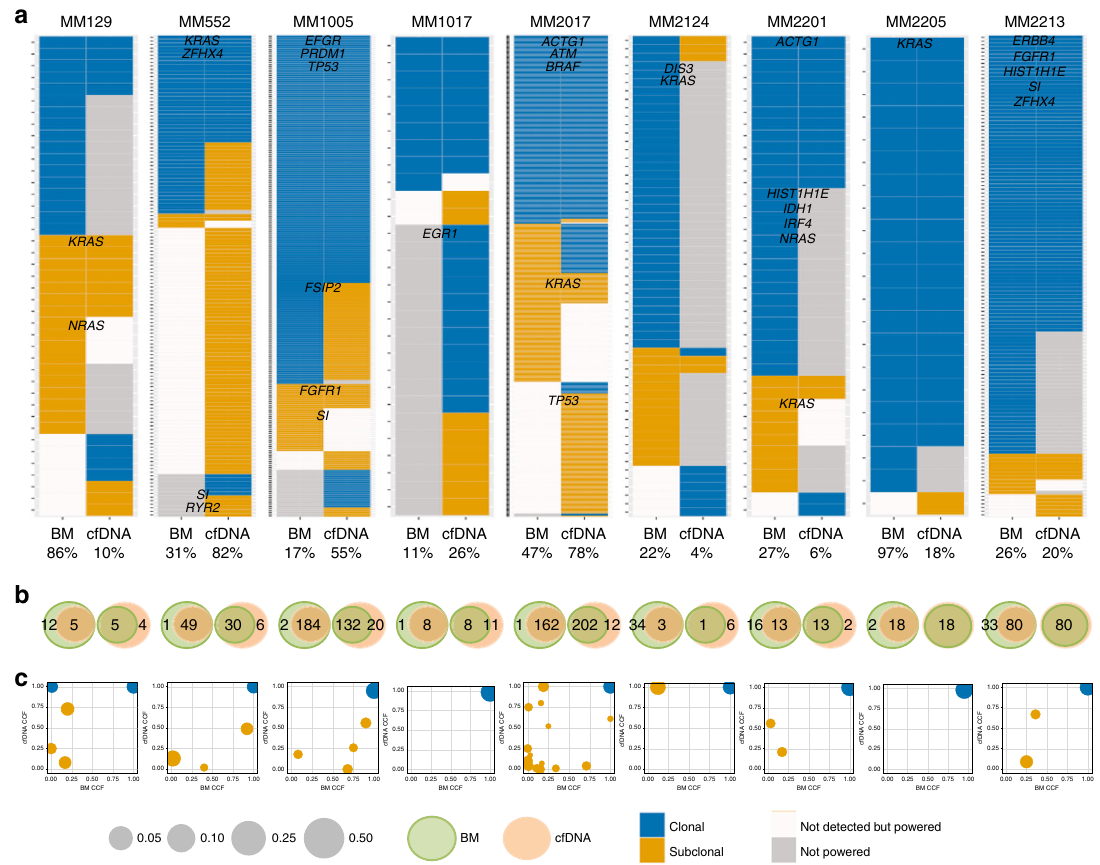
Fig. 6 Whole-exome sequencing of matched cfDNA and BM tumor samples. a Presence of clonal (navyblue) and subclonal (yellow) somatic mutations in BM and cfDNA WES is presented. Mutations that were not detected with ≥ 0.9 detection power are shown in snow, and mutation sites with <0.9 detection power are shown in gray. MM and actionable pan-cancer related genes and purity of each sample are indicated. b Left Venn diagram shows the number of clonal mutations that were present in bone marrow biopsies (green) and con fi rmed in cfDNA samples (orange). Right Venn diagram shows the number of clonal mutations that were present in cfDNA samples (orange) and con fi rmed in bone marrow biopsies (green). c Cancer cell fraction (CCF) for clusters of SSNVs detected in bone marrow and cfDNA samples from the same MM patient. Mutations were clustered by CCF for each pair of samples using a PHYLOGIC. Clonal (navyblue) SSNVs were de fi ned as events having ≥ 0.9 CCF in both samples. Subclonal (yellow) SSNVs were de fi ned as events having <0.9 CCF in samples. Size of circles indicated the fraction of SSNVs. Mutations having ≥ 0.9 detection power in both samples are shown and clusters